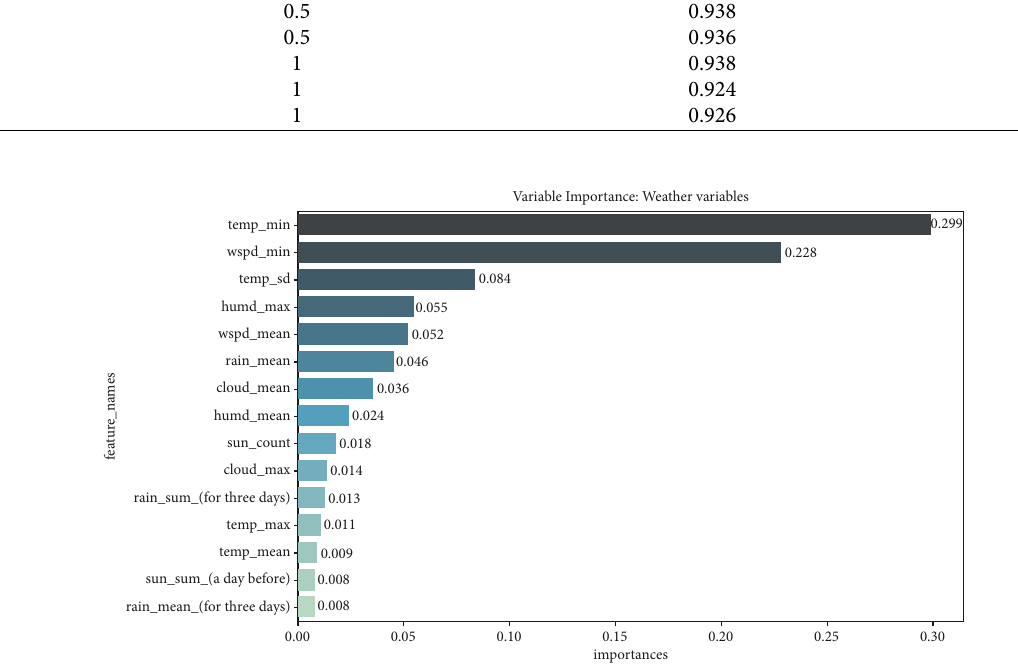
Figure 2: Variable importance of weather variables in the XGBoost model.